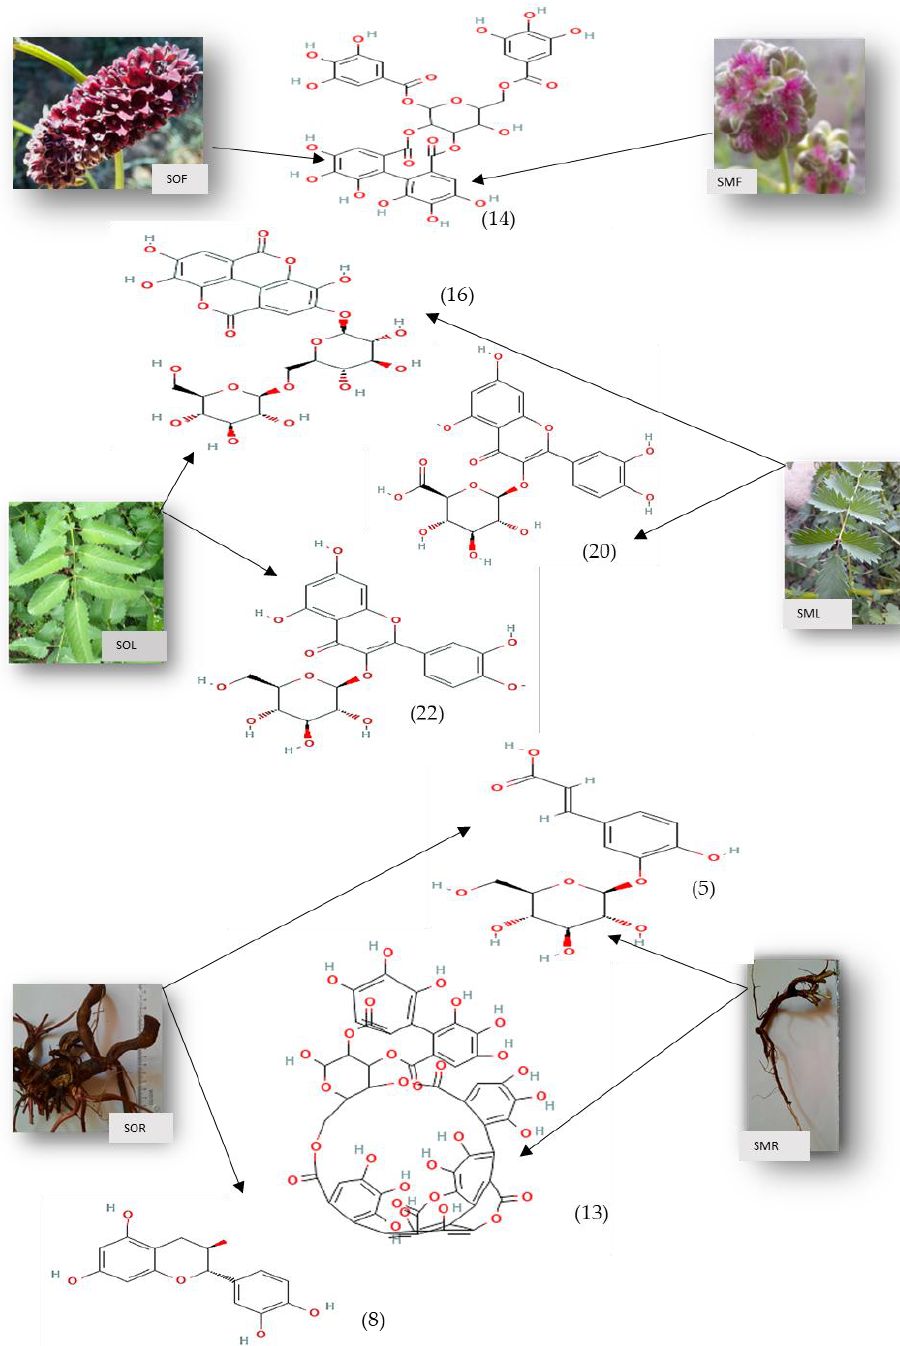
sented in Figure 3.